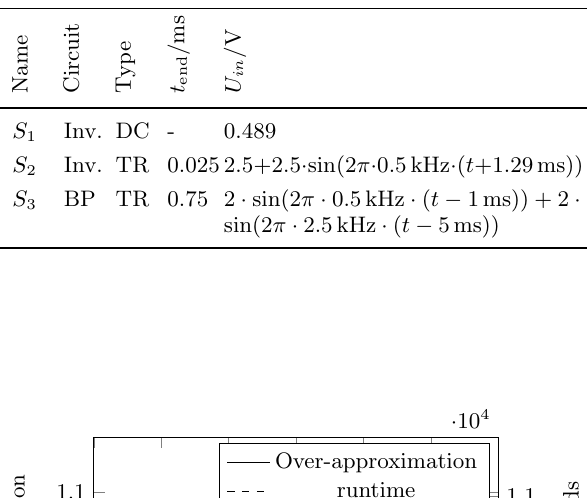
Table 3: Simulation setups used for BJT Inverter (Inv.) in Fig. 11 and Bandpass (BP) in Fig. 12